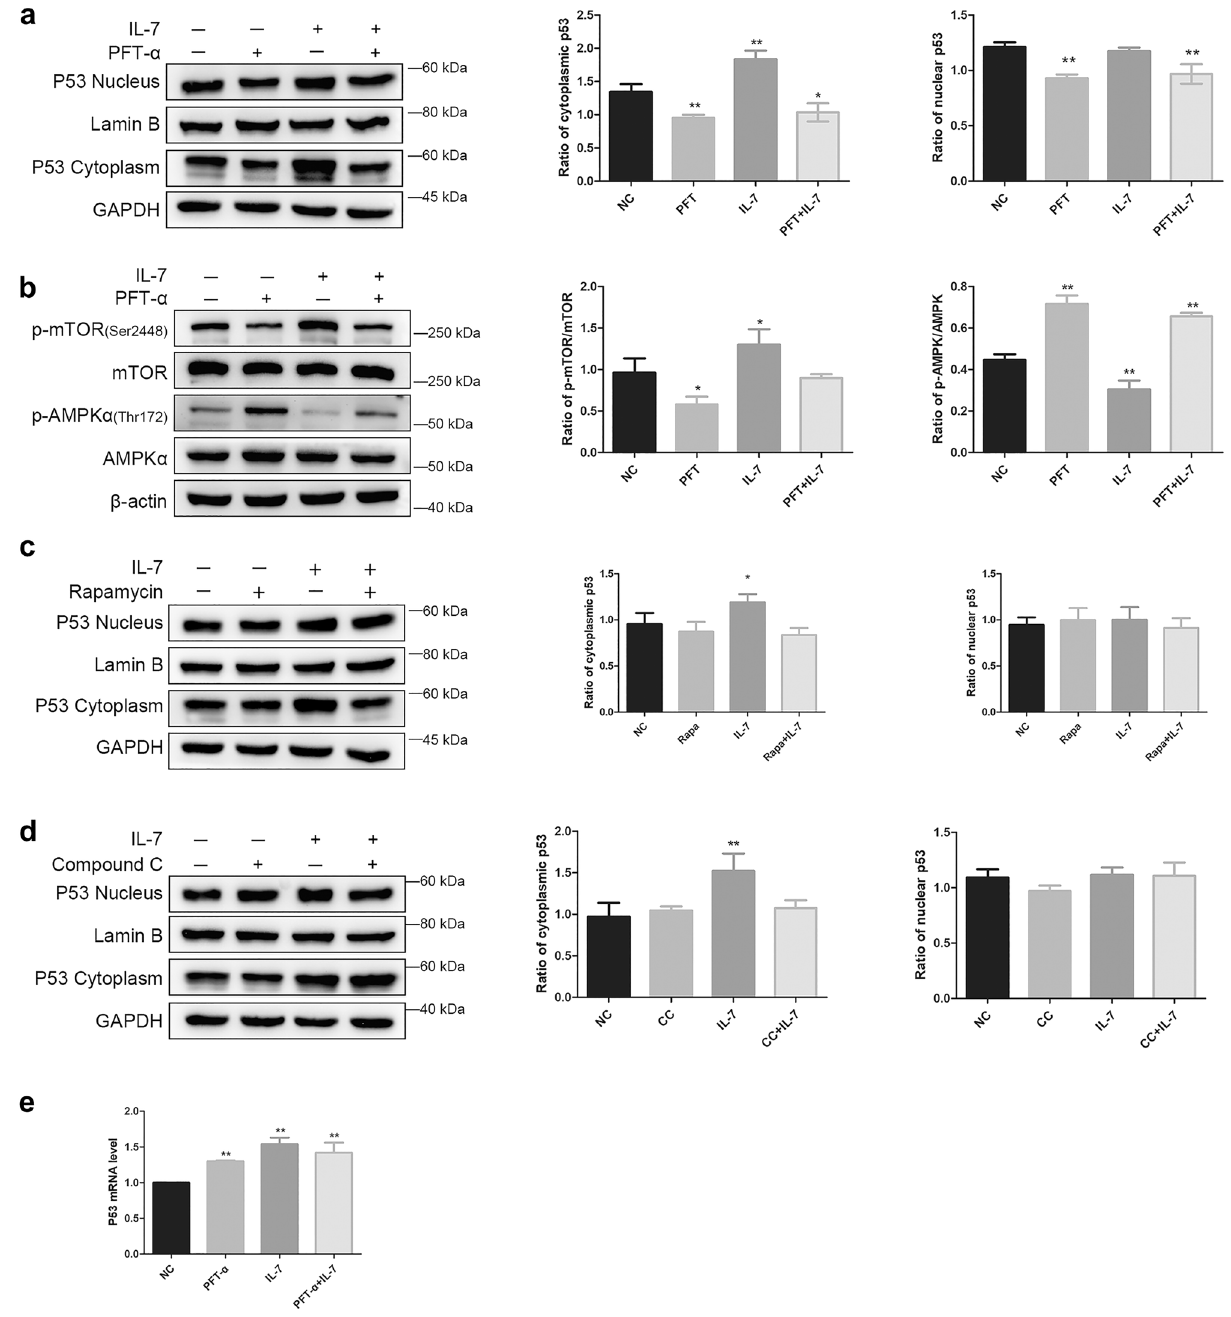
Figure 4. IL-7 regulate AMPK and mTOR via P53. ( a ) Cells were treated with PFT-α, western blot analysis show nucleus and cytoplasmic p53 slightly decrease, besides, PFT-α blunt the effect of IL-7 modulated p53 translocation from nucleus to cytoplasm. ( b ) PFT-α cause the up-regulation of p-AMPK/AMPK and down- regulation of p-mTOR/mTOR, and impede the effect of IL-7 on A549 cell. ( c ) Cell treated with Rapamycin, neither nuclear p53 nor cytoplasmic p53 were affected. ( d ) Cell incubated with Compound C, there is no significant change on p53 nucleus and cytoplasm. ( e ) qRT-PCR show both PFT-α and IL-7 cause increase of p53 mRNA level. All the bar graph expressed as Mean ± SD, n = 3. *represent for P < 0.05 versus negative control (NC). **represent for P < 0.01 versus